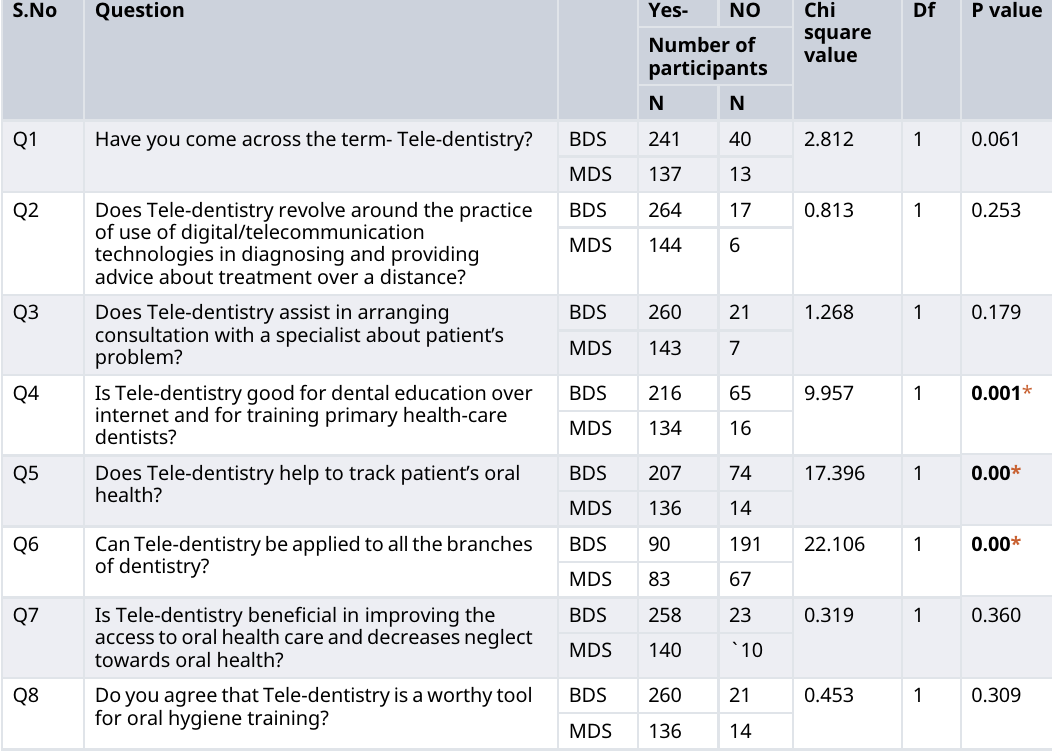
Table 2. Chi square test for qualification of the study participant and response regarding teledentistry. S.No